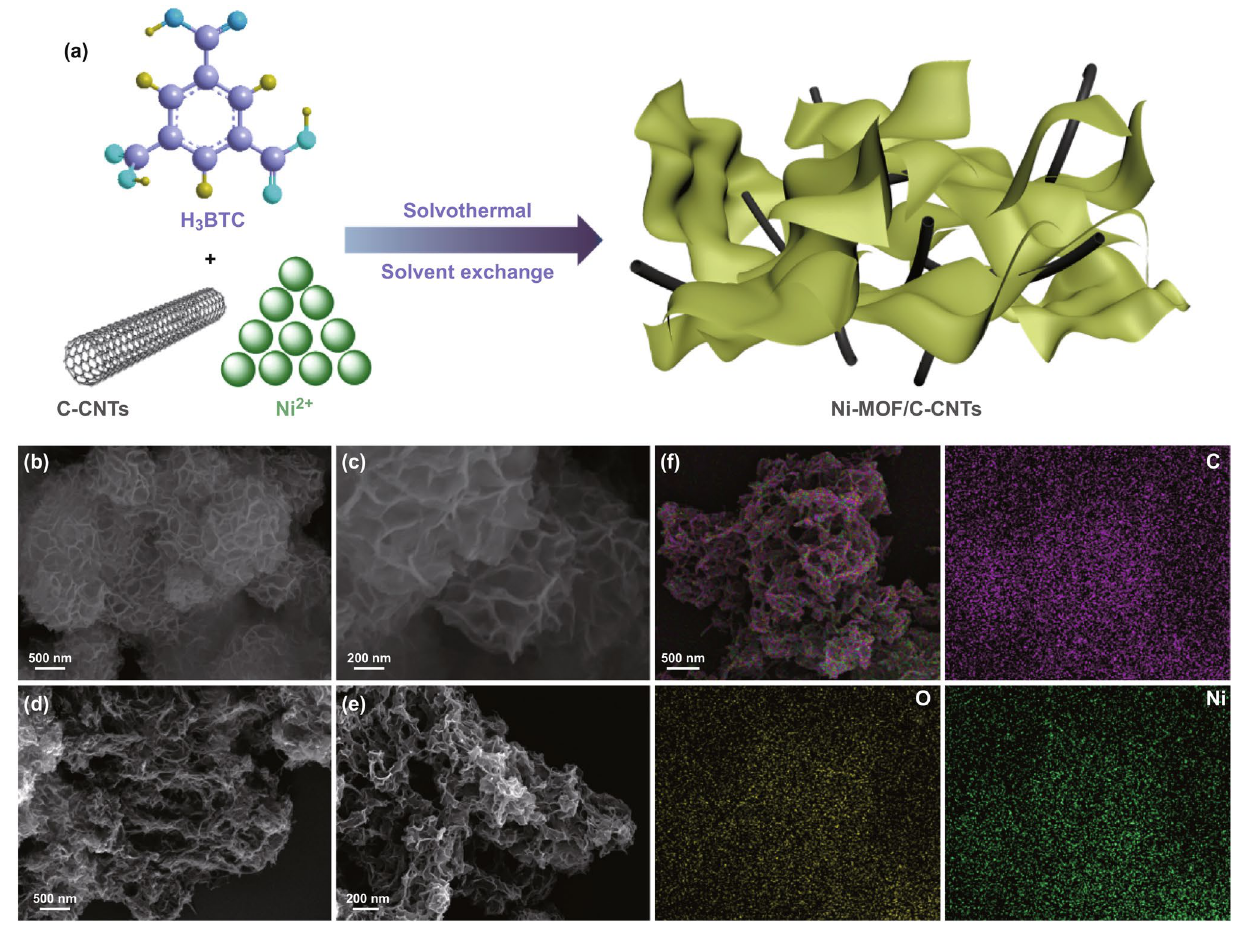
Fig. 1 a Schematic illustration for the synthesis of ultrathin Ni-MOF/C-CNTs nanosheets. SEM images of as-synthesized b , c Ni-MOF, and d , e Ni-MOF/C-CNTs40 nanosheets. f EDS mapping for C, O, and Ni elements of the